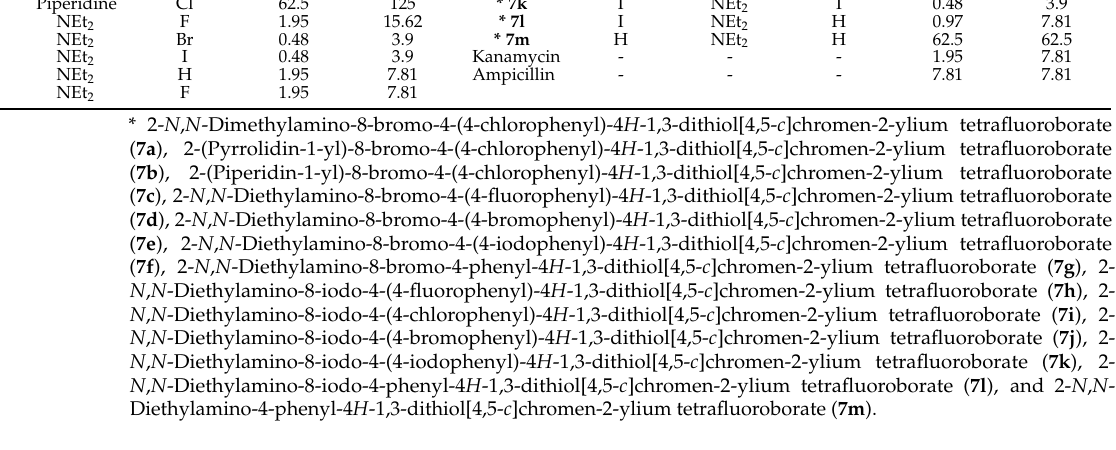
Figure 23. SAR analysis of sulfur-containing tricyclic flavonoids against S. aureus and E. coli [89]. Table 13. Sulfur-containing tricyclic flavonoids ( 7a – m ) as antibacterial agent. Farooq et al. (2020) synthesized three chalcone derivatives and evaluated their anti- Com. No. Com. No. bacterial action against S. aureus via disc diffusion assay and turbidimetric kinetics. The